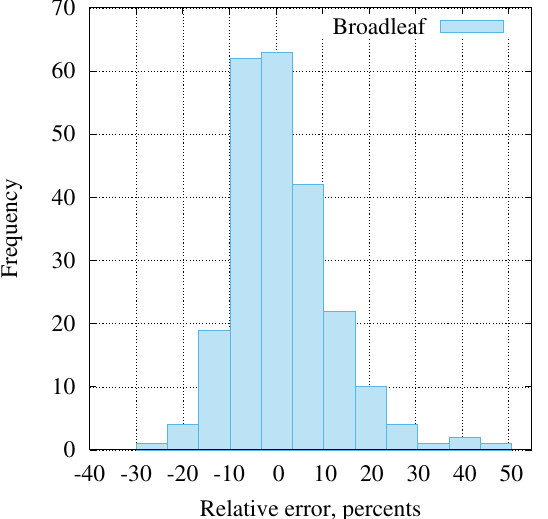
Figure 8. Relative errors of simulated spectra, broadleaf